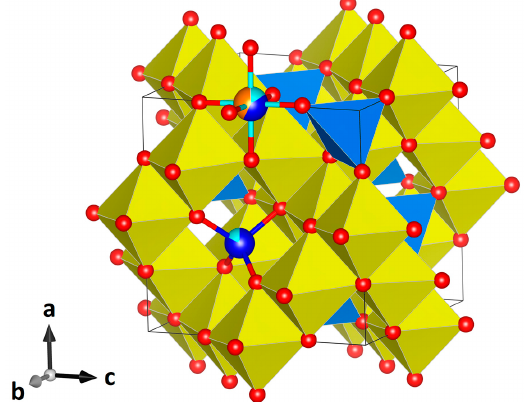
Figure 1. Spinel structure of Li 0.5 Zn 1.67 Sb 0.83 O 4 . The different colors in the spheres represent the degree of occupation of each element. O (red), Li (green), Zn (blue), and Sb (brown). The polyhedra are centered at the octahedral and tetrahedral sites. Table 1. Crystallographic data and refinement of the compound Li 0.5 Zn 5/3 Sb 2.5/3 O 4 .